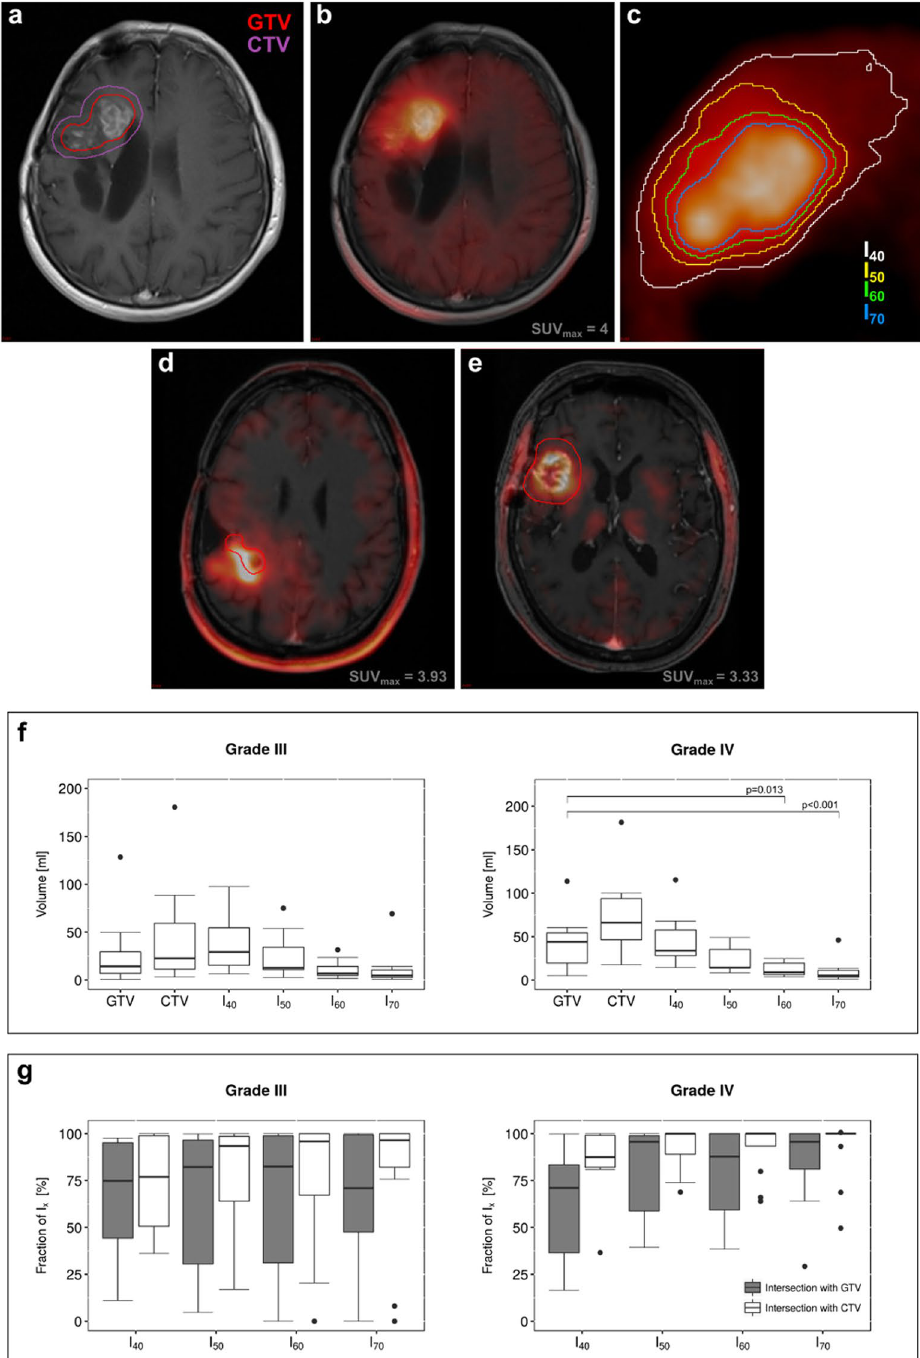
Figure 1. Amino acid PET with 18 F-FET in radiotherapy treatment planning of recurrent high grade glioma. Current standard definition of radiotherapy gross tumor volume (GTV, red) and clinical target volume (CTV, purple) are based on T 1 weighted contrast-enhanced (T 1 CE) MRI ( a ). Amino-acid PET using 18 F-FET is postulated to improve target delineation by assessment of tumor metabolism ( b ). However, defining an appropriate cut-off for PET-active tumor region is challenging, see e.g. different PET based tumor volumes based on selected thresholds (%) from the maximum intensity (isocontours I x , c ). Comparative analysis of PET vs. MRI volumes (GTV, red) may result in substantial mismatched ( d ) or a relatively good overlap ( e ). Four different contouring techniques, using percentage threshold of the maximum standardized tracer uptake value (SUV max ), i.e. 40% (white), 50% (yellow), 60% (green) and 70% (blue) isocontours were used for segmentation of 18 F-FET active volumes ( c ). These volumes were then compared to T 1 CE MRI based radiotherapy target volumes (GTV and CTV). Boxplots show the distribution of the individual volumes in grade III and IV recurrent glioma, respectively ( f ). Isocontours of 60% and 70% yielded significantly smaller volumes